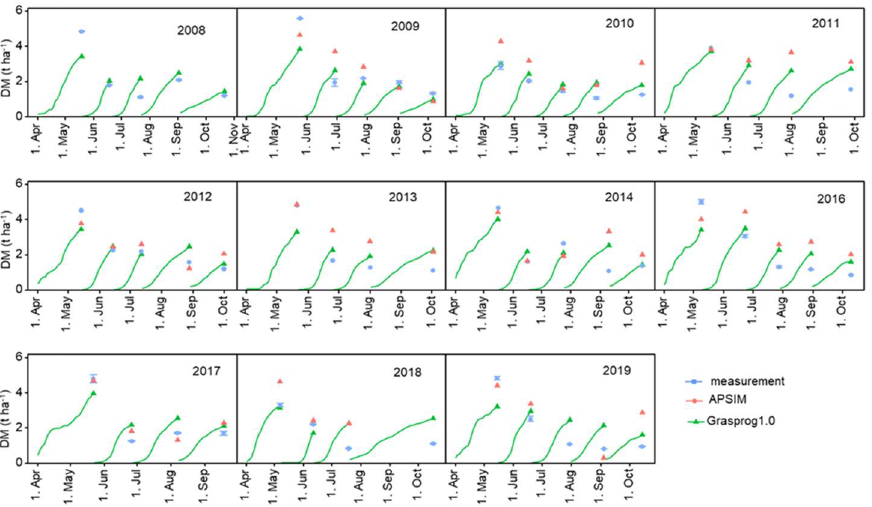
Figure 5. Measured grass dry matter (DM) for different cuts and years for Aulendorf, Germany. The predictions by GrasProg1.0 and APSIM are also shown.